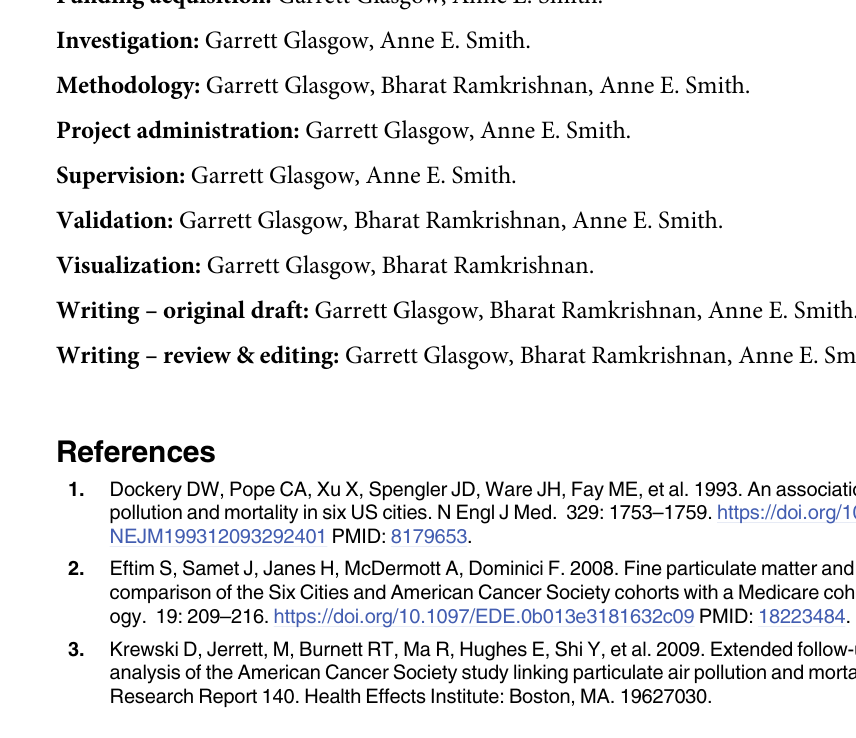
S12 Fig. Spline Estimates of same “true” C-R function under varying amounts of measure- ment error (threshold 9.5 μ g/m 3 , hazard ratio 1.005). (TIF) S13 Fig. Spline estimates of same “true” C-R function under varying amounts of measure- ment error (threshold 9.5 μ g/m 3 , hazard ratio 1.01). (TIF) S14 Fig. Spline estimates of same “true” C-R function under varying amounts of measure- ment error (threshold 9.5 μ g/m 3 , hazard ratio 1.02). (TIF) S15 Fig. Spline estimates of same “true” C-R function under varying amounts of measure- ment error (threshold 9.5 μ g/m 3 , hazard ratio 1.05). (TIF) S1 Table. Rejection of the no C-R threshold model under varying amounts of measurement error (2 × Δ LL > 2). (PDF) S2 Table. Rejection of the no C-R threshold model under varying amounts of measurement error (2 × Δ LL >